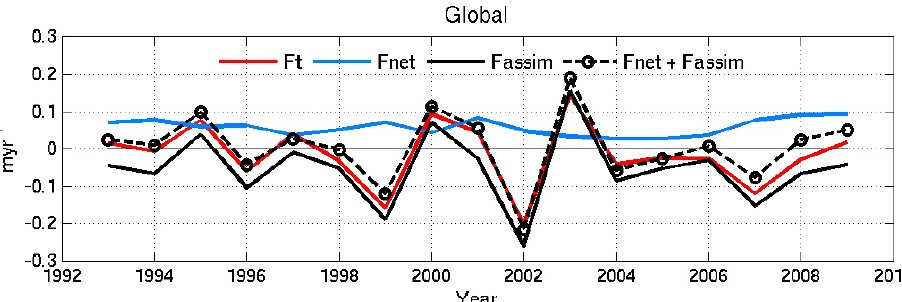
Fig. 7. Annual time series of the global ocean freshwater budget from 1993–2009. The terms are Fnet, the surface freshwater flux; Fassim, the equivalent freshwater flux coming from data assimilation increments vertically integrated; and Ft, the freshwater storage associated with changes in global mean